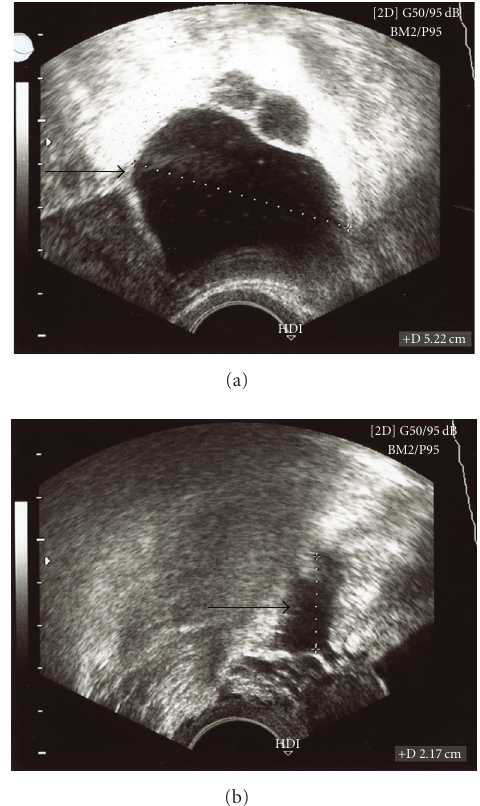
Figure 2: Haematoxylin and Eosin (HE) Staining of the left fallop- ian tube: (a) low magnification, and (b) high magnification. Di ff use Central necrosis and caseation with epithelioid and multinucleated giant cell (Langerhans) infiltration are